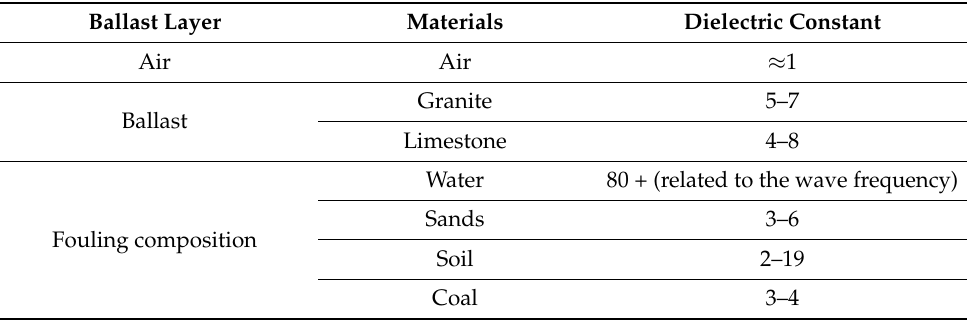
Table 1. Dielectric constants of common materials in ballast layer. Ballast Layer Materials Dielectric Constant Air Air ≈ 1 Granite 5–7 Ballast Limestone 4–8 Water 80 + (related to the wave frequency) Sands 3–6 Fouling composition Soil